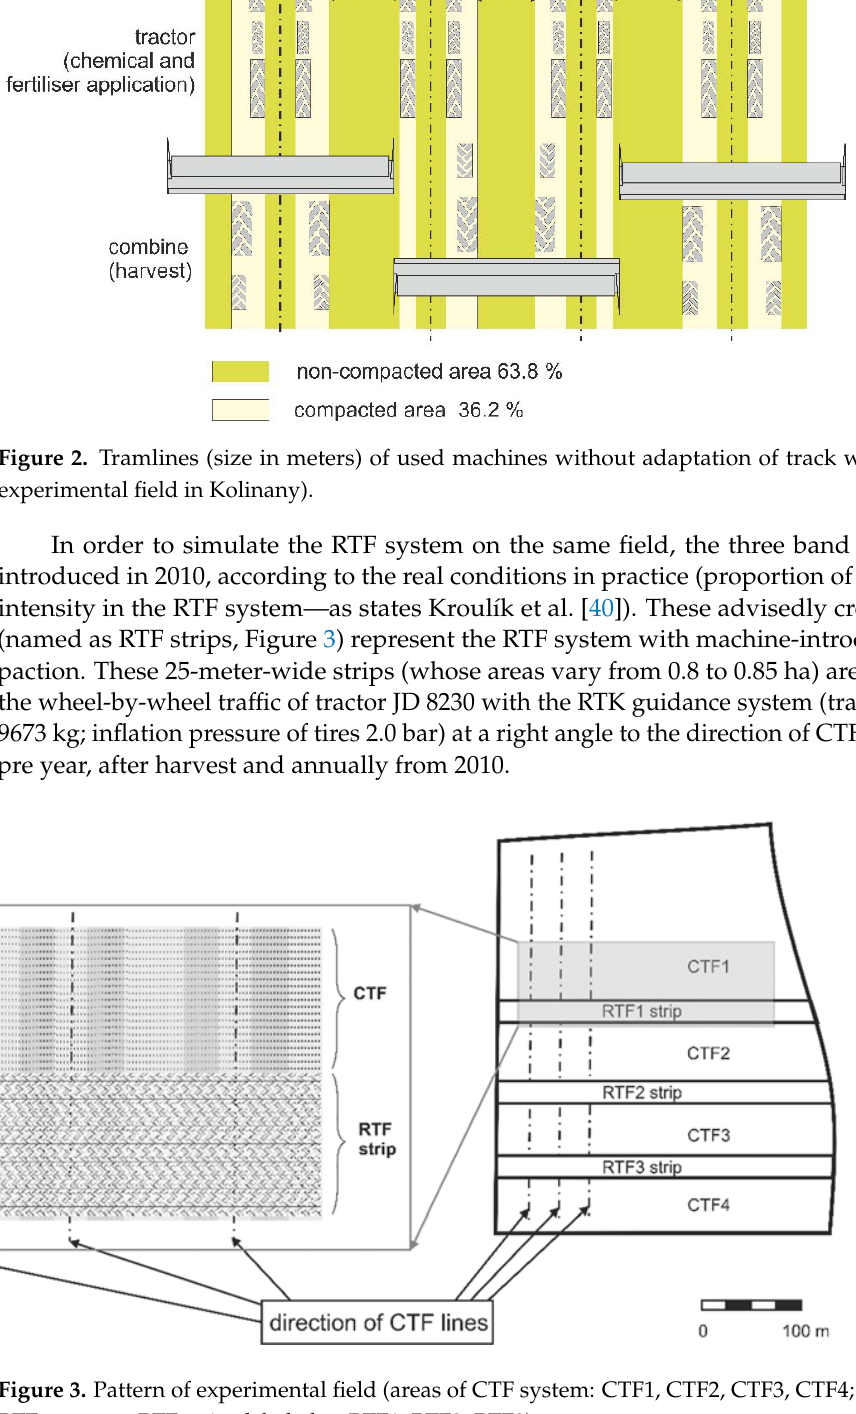
Figure 3. Pattern of experimental field (areas of CTF system: CTF1, CTF2, CTF3, CTF4; and areas of RTF system = RTF strips labeled as RTF1, RTF2, RTF3).